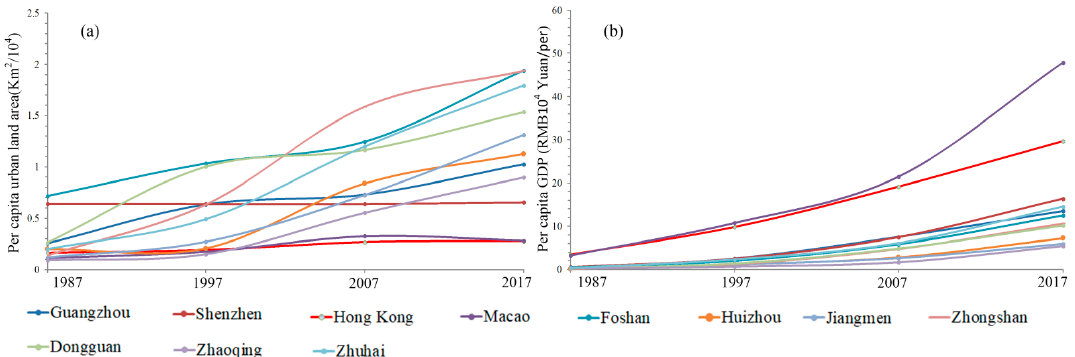
Figure 10. The per capita urban land area ( a ) and per capita GDP ( b ) of different cities in the GBA from 1987 to 2017.